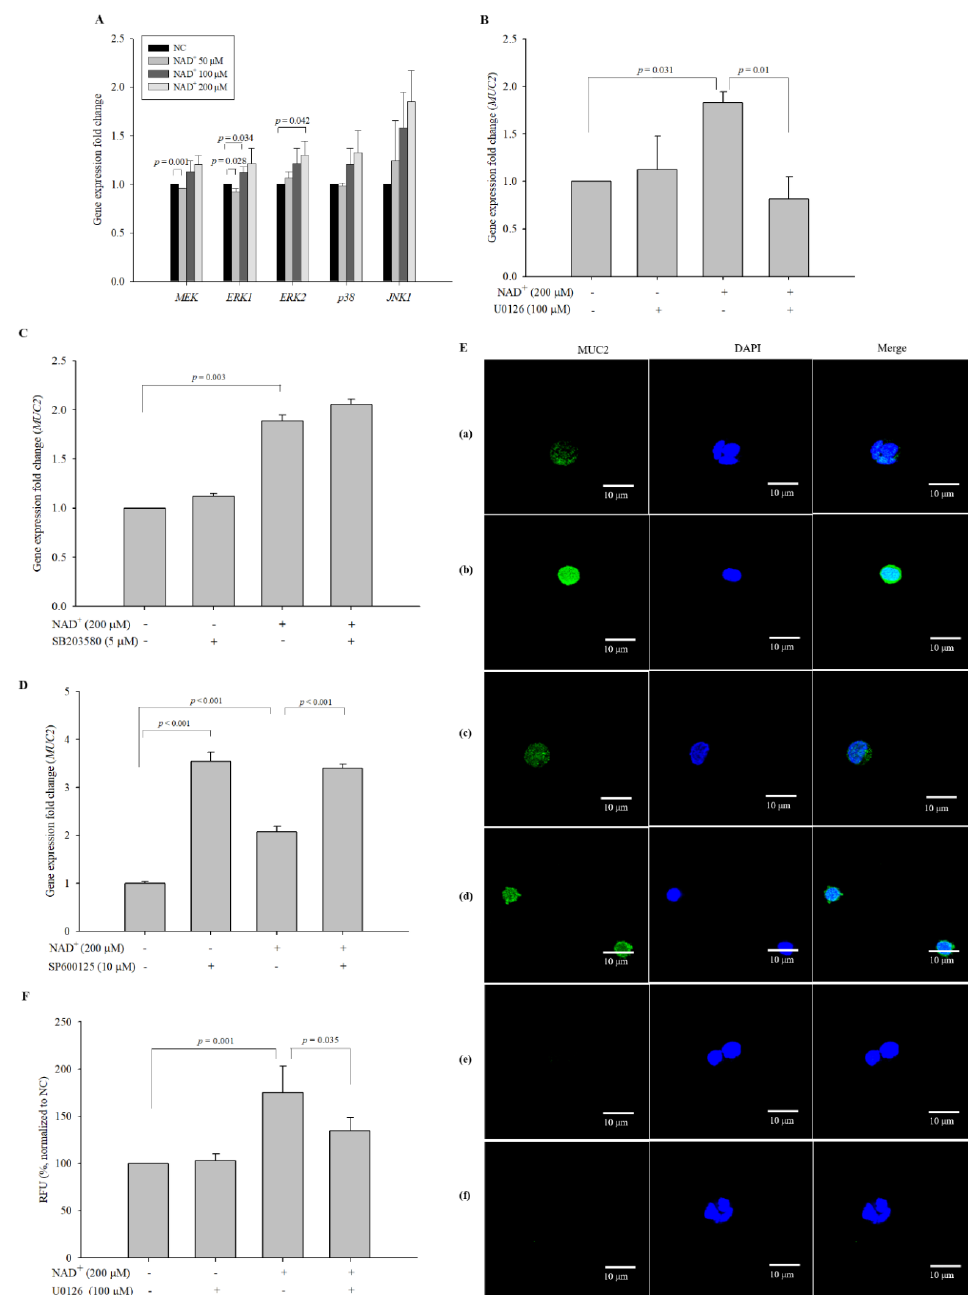
Figure 8. Extracellular signal-regulated kinase (ERK)1/2 is involved in MUC2 expression in NAD + -treated cells. ( A ) qPCR was performed to measure the expression levels of MEK , ERK1 , ERK2 , p38 , and JNK1 . U0126 blocked the stimulation of MUC2 expression caused by treatment with 200 µM NAD + at the gene level ( B ), while SB203580 and SP600125 did not inhibit MUC2 expression caused by treatment with 200 µM NAD + ( C , D ). U0126 blocked the stimulation of MUC2 expression caused by treatment with 200 µM NAD + at the protein level, as assessed using ICC (magnification 600×) (E). To clarify that the secondary antibodies were not affected the generation of fluorescence signal, the preparations of the negative control and 200 µM NAD + -treated cells were created by omitting the primary antibody. ( a ) Negative control, ( b ) 200 µM NAD + , ( c ) 100 μM U0126, ( d ) 200 µM NAD + , and 100 μM U0126, ( e ) negative control without the primary antibody, ( f ) 200 µM NAD + without the primary antibody. The fluorescence intensity was quantified ( F ). The data are expressed as the mean ± SD of three independent experiments performed in triplicate. The symbols + and − indicate chemical treatment and non-treatment,